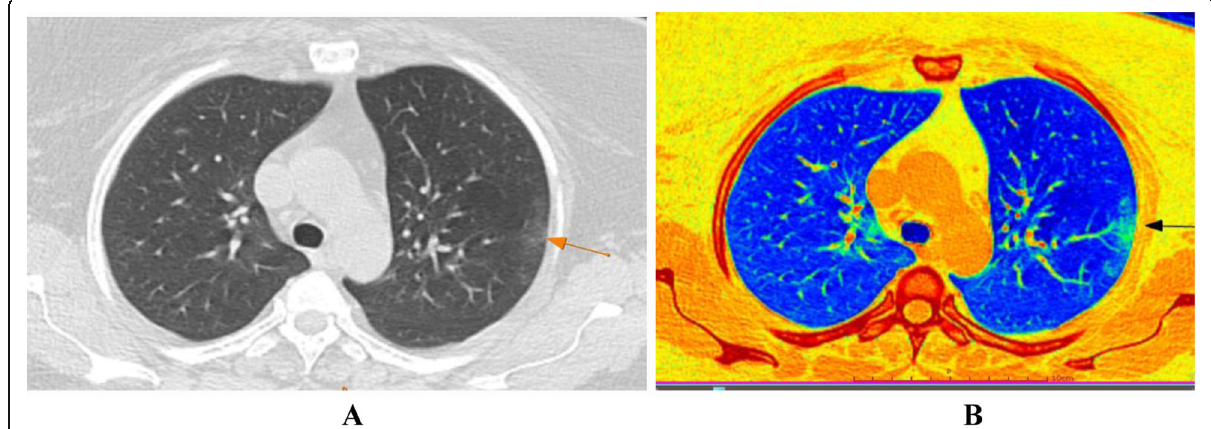
Fig. 2 A 40-year-old female patient with first presentation with minimal cough and sore throat; CT-SSS was 2. Follow-up revealed complete resolution of the symptoms after 13 days from the onset. a MDCT chest, axial cuts show suspected faint peripheral sub-pleural patchy ground glass opacity seen in the left lung upper lobe apico-posterior segment; confirmed by the color coded images ( b ) with HU more than −